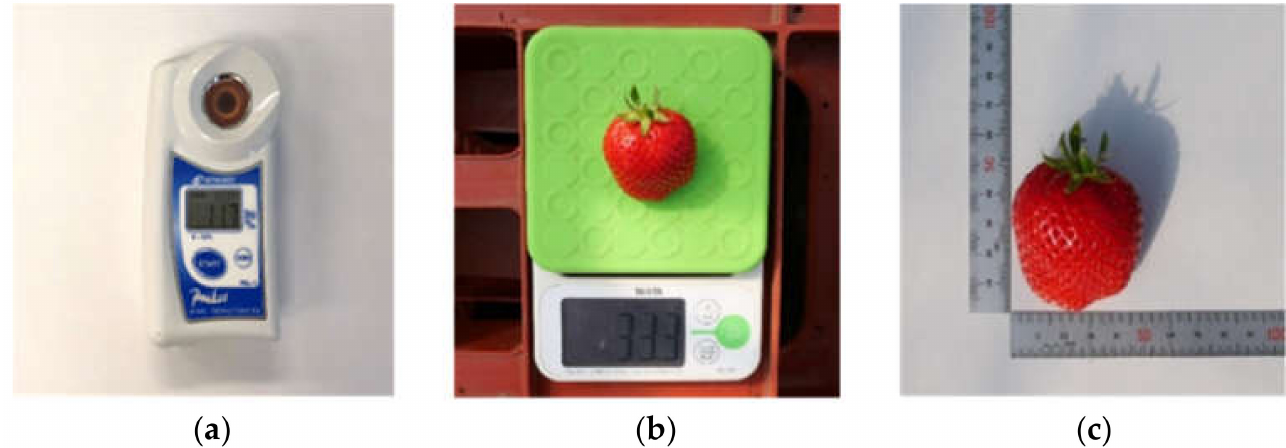
Figure 4. Examples of strawberry ( a ) saccharimeter; ( b ) strawberry weight; ( c )